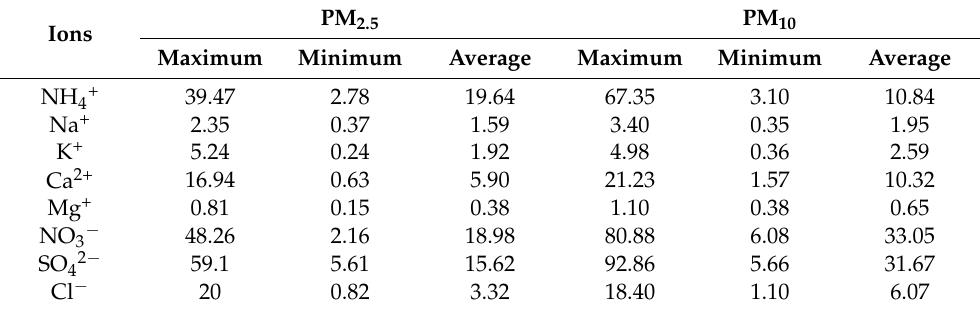
Table 2. The concentrations of water-soluble inorganic ions from atmospheric particles ( µ g · m − 3 ).